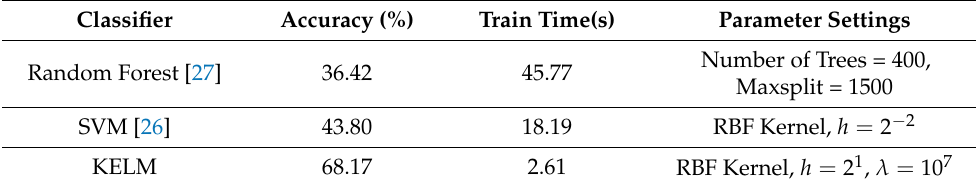
Table 5. Classification accuracy with 6 selected motion